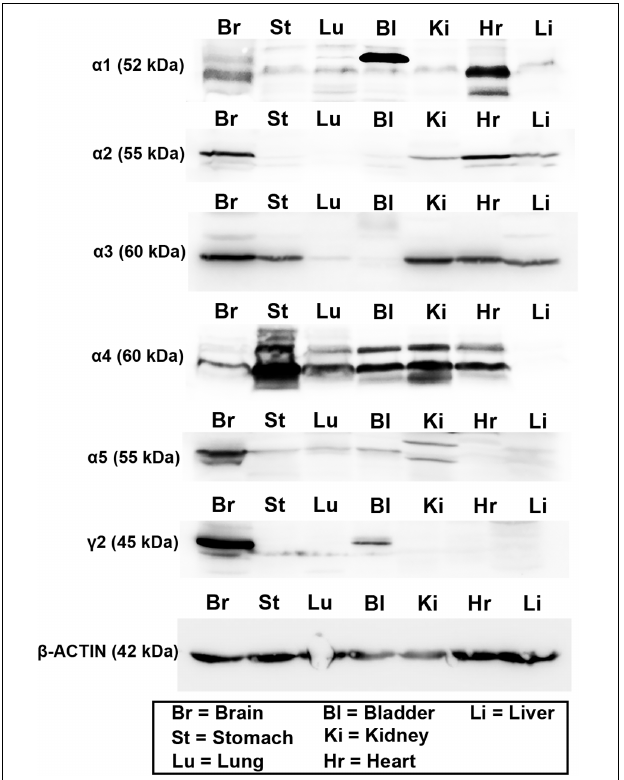
FIGURE 2 | Protein expression of the major GABA A R α and γ subunits within various organs of the mouse. Representative western blots for GABA A R α 1–5 and γ 2 subunits using tissue homogenates from whole brain (Br), stomach (St), lung (Lu), bladder (Bl), kidney (Ki), heart (Hr), and liver (Li) obtained from adult male C57BL/6 mice. Western blots for the different subunits in the peripheral organs corresponded to the sizes of those obtained from the brain. Note that blots for actin were run on separate gels due to the similar molecular weight of this protein compared to GABA A R subunits. N = 3